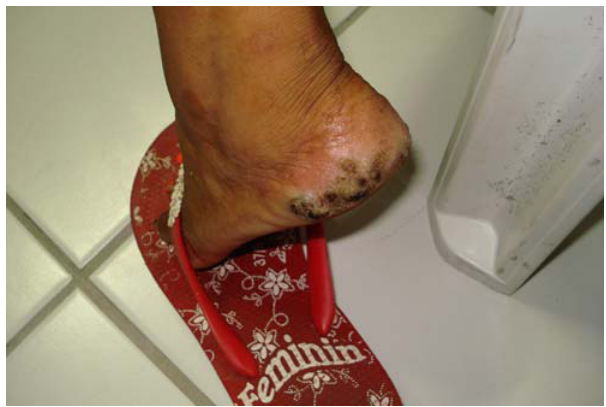
Figure 3. Multiple lesions on the left heel of a 13 year-old Brazilian